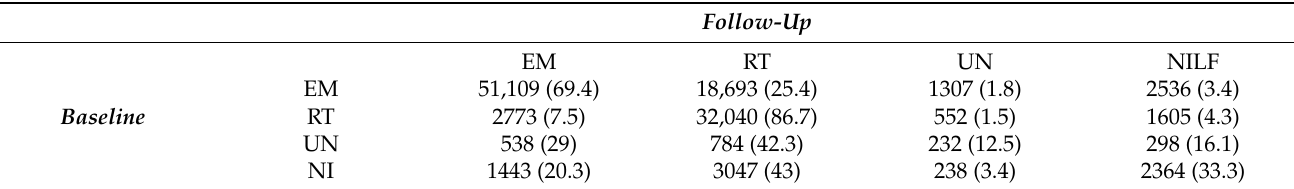
Table 1. Number of participants by employment transition from baseline to follow-up.